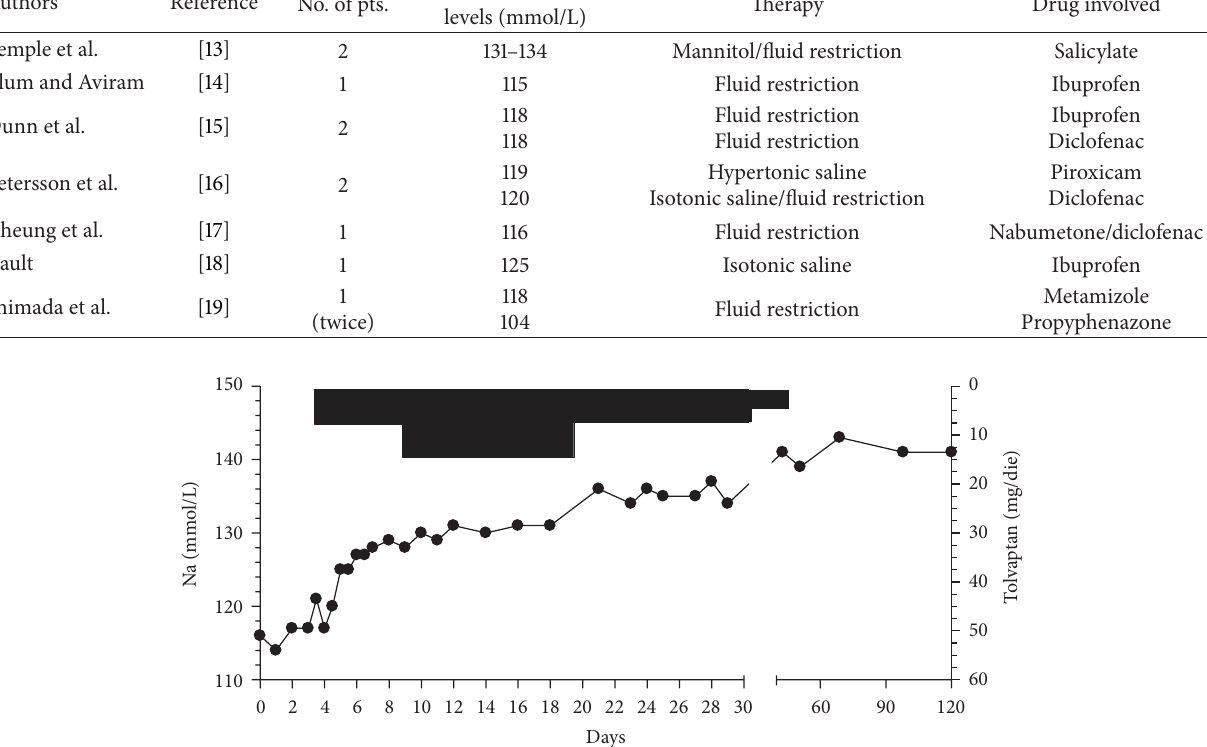
Figure 1: Time course of serum sodium levels during tolvaptan